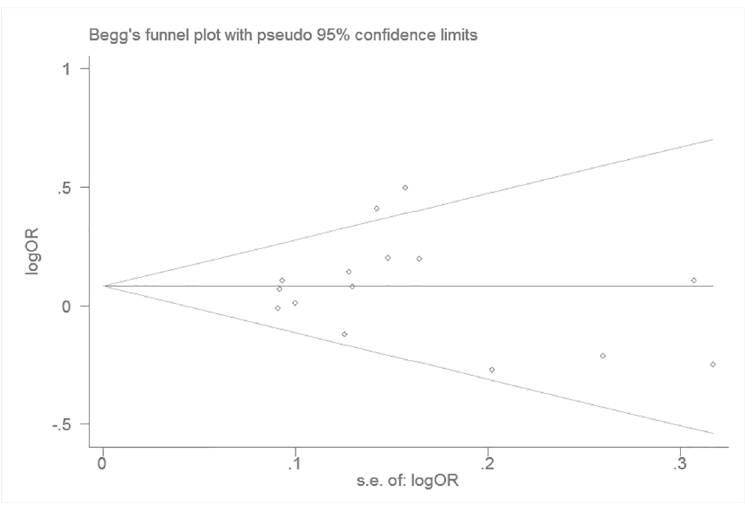
Fig 3. Begg’s funnel plot for publication bias analysis association between the TERT rs2853669 polymorphism and cancer risk (CT vs. TT).